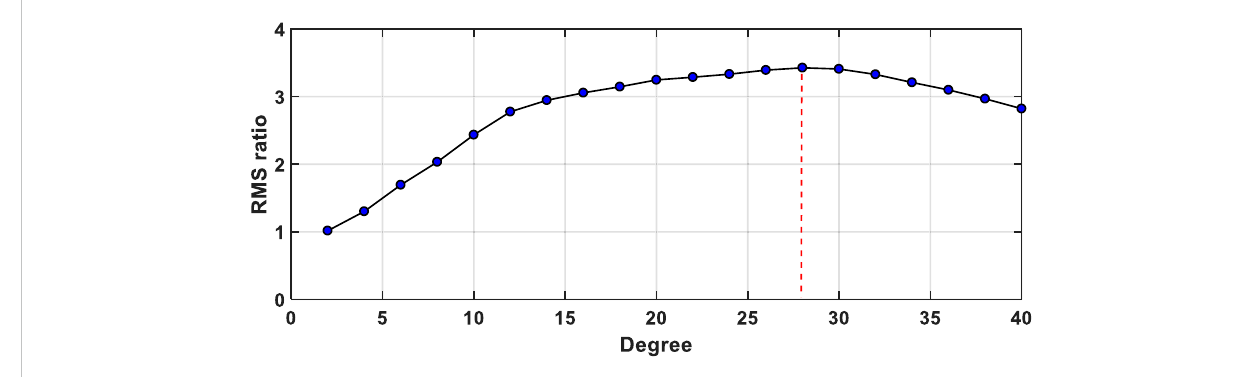
FIGURE 2 The mean RMS_ ratios with the increasing degree (no fi ltering) over April 2002 to August 2016.